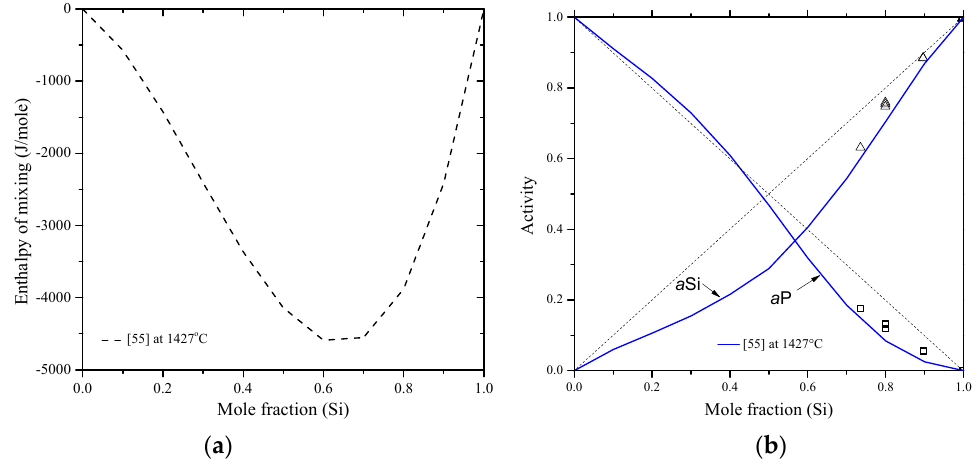
Figure 30. ( a ) Calculated enthalpy of mixing of the P-Si liquid at 1427 °C; ----: [55]; ( b ) activity of Si and P in the P-Si liquid at 1427 °C; ----: [55]; □ and Δ : [263].